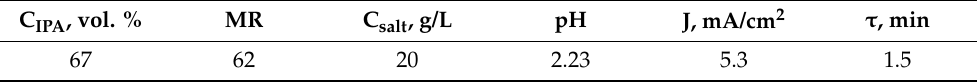
Table 1. Parameters of the reaction medium for